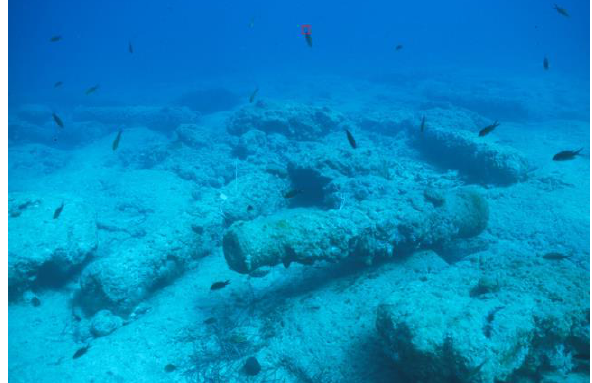
Figure 10. Results of shape detection for log-DODE algorithm Preliminary test results and comparison between the three algorithms are shown in the following table.